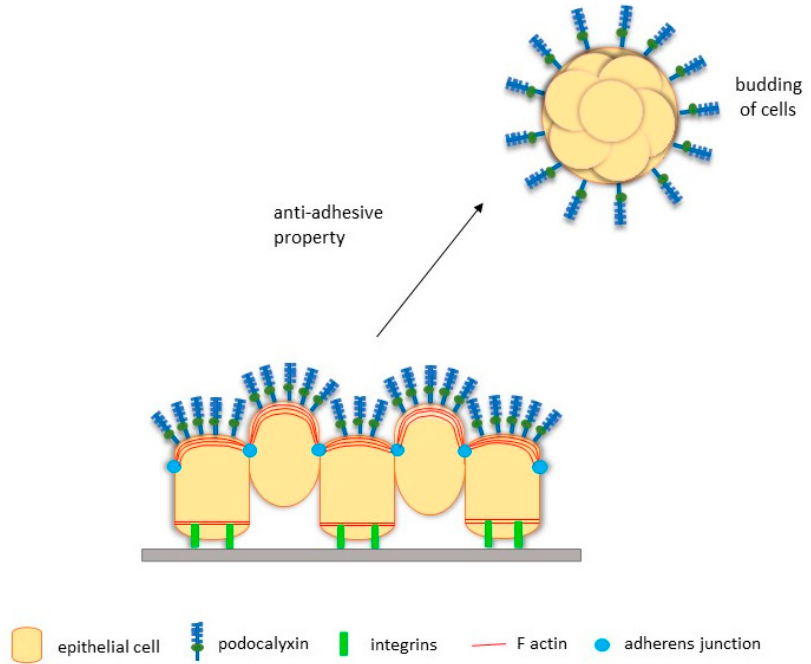
Figure 3. Proposed mechanisms of high levels of PODXL expression in cancer cells to promote tumour budding. Adapted from McNagny and Hughes [20].